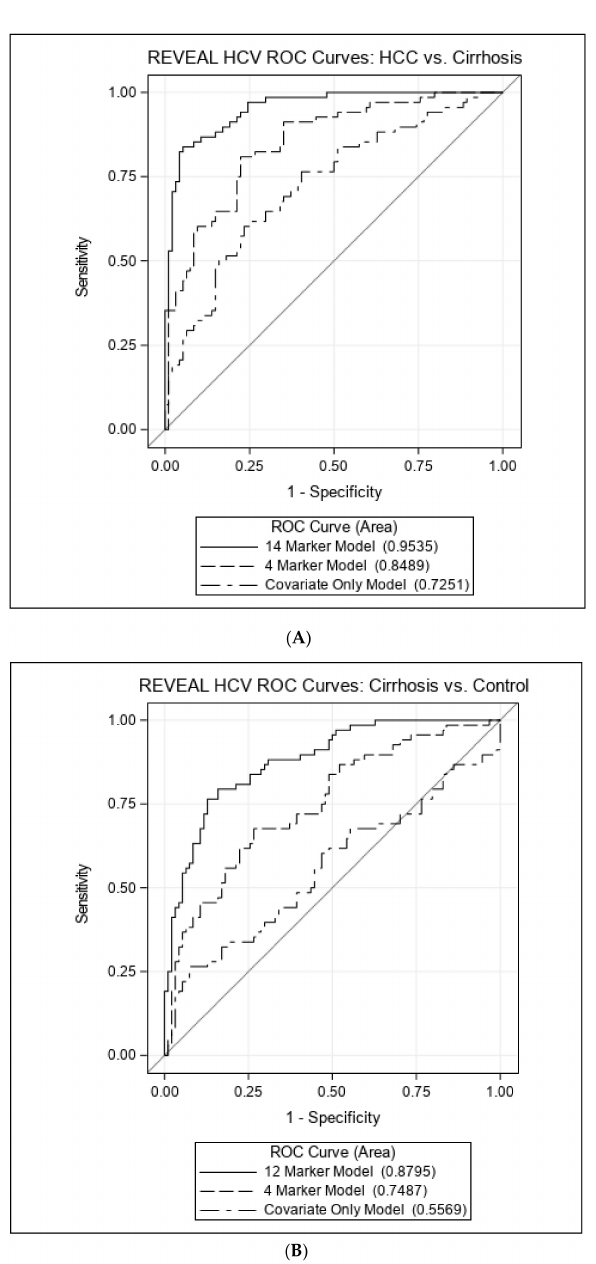
Figure 2. Receiver operating characteristic (ROC) curves comparing predictive models. ( A ) Com- parison between cirrhotic participants and controls. Twelve marker model: CCL18, DEFA1, REG1A, ARTN, CCL3, CCL4, CD40, CXCL10, EN-RAGE, LAPTGF-B1, MCP-4, PD-L1 + covariates. Four marker model: DEFA-1, ITGAM, CCL11, SCF + covariates. Covariate Only Model: age, sex, years of follow-up, serum alanine aminotransferase (ALT) level, alcohol, and smoking ( B ) Comparison between HCC and cirrhotic participants. Fourteen marker model: CCL18, DEFA1, ITGAM, REG1A, SERPINA7, ARTN, CASP-8, CD40, EN-RAGE, FGF-23, IL7, LAPTGF-B1, PDL1, VEGFA + covariates. Four marker model: DEFA-1, ITGAM, CCL11, SCF + covariates. Covariate Only Model: age, sex, years of follow-up, serum alanine aminotransferase (ALT) level, alcohol, and